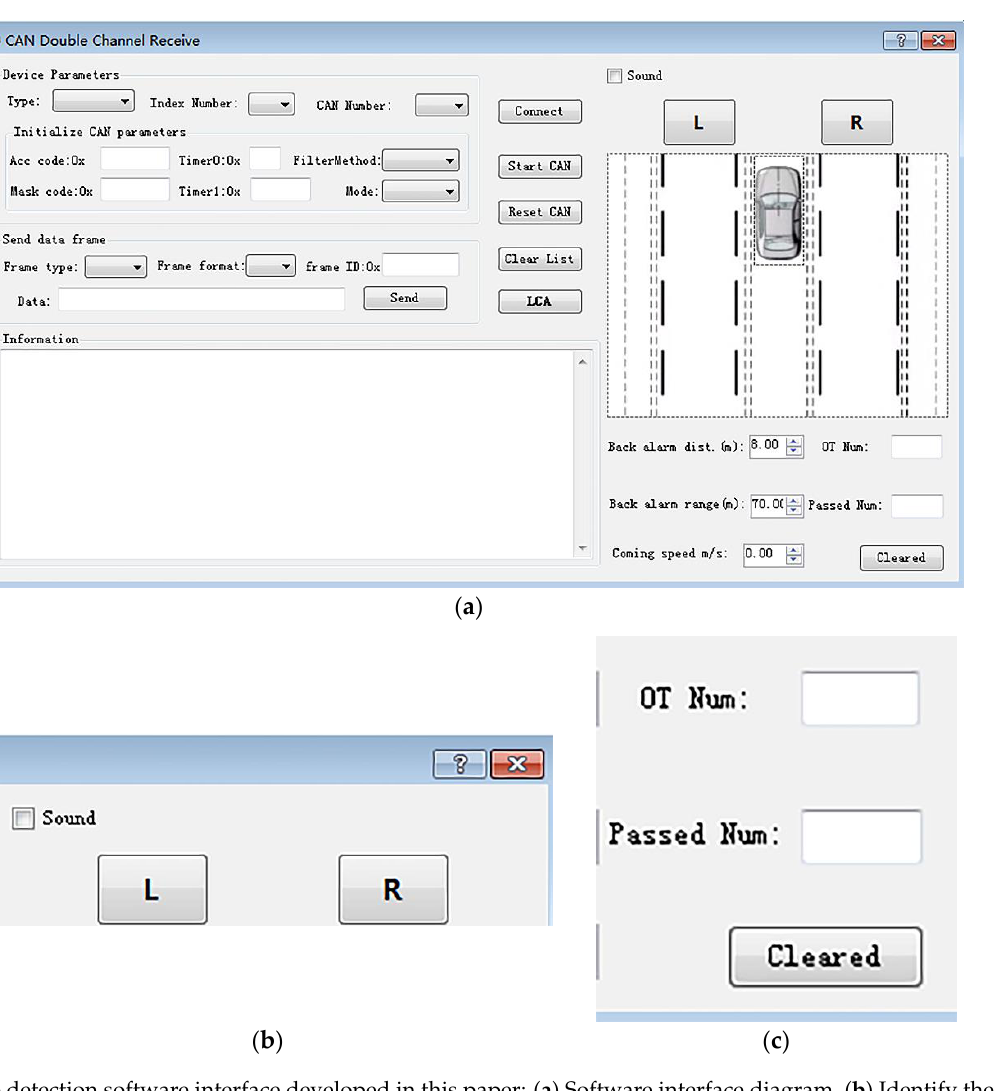
Figure 1. Schematic diagram of the algorithm for overtaking recognition in lanes on both sides of the main vehicle.